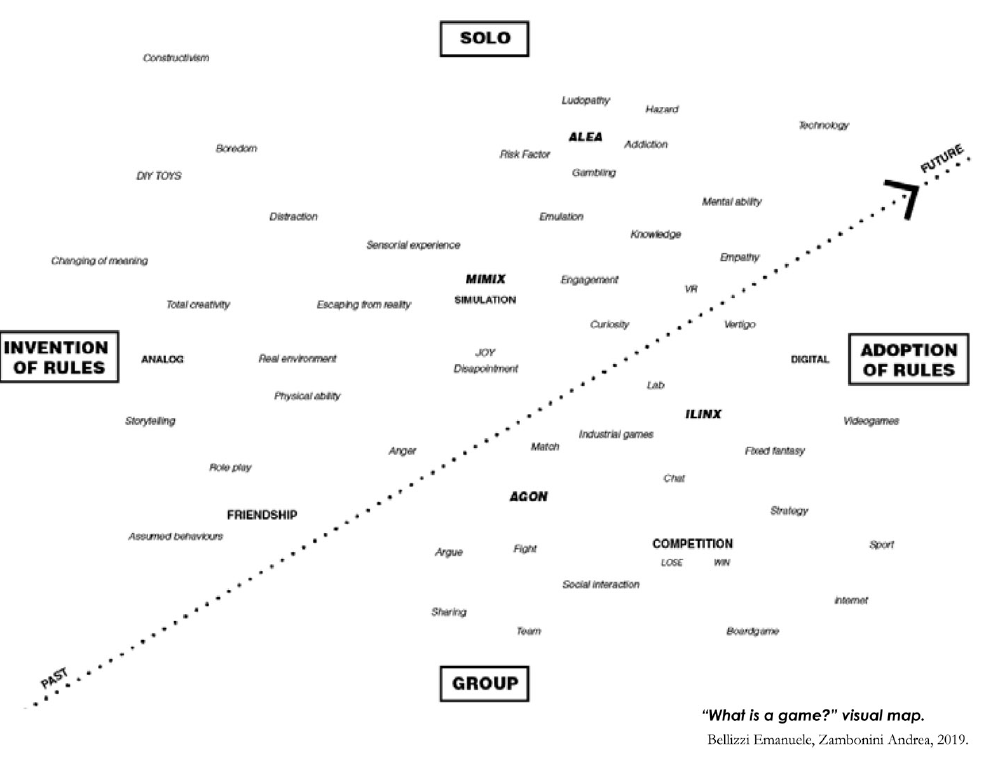
Fig. 8 Bellizzi E.,